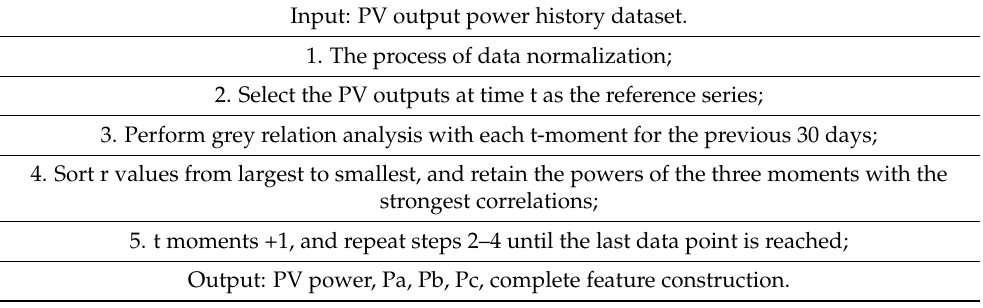
Table 2. Similarity feature selection